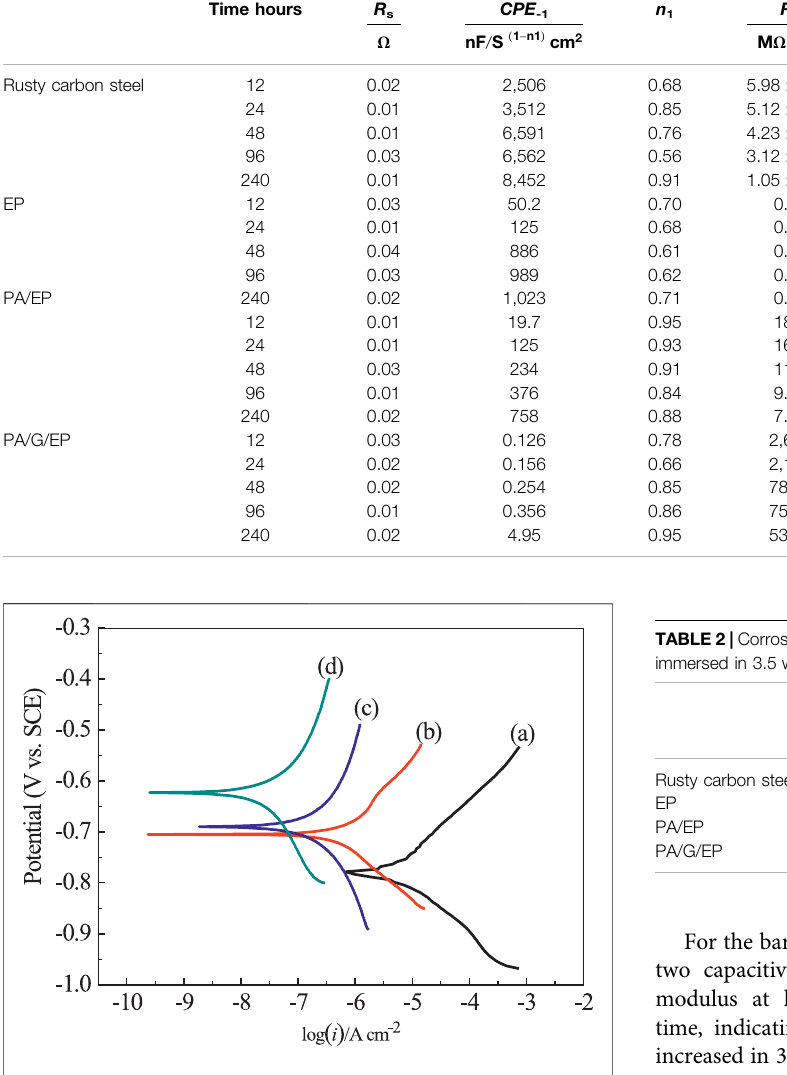
FIGURE9| Thepolarizationcurvesofrustycarbonsteel (A) ,EP (B) ,PA/ EP (C) , and PA/G/EP (D) immersed in 3.5 wt% NaCl solution after 240 h.